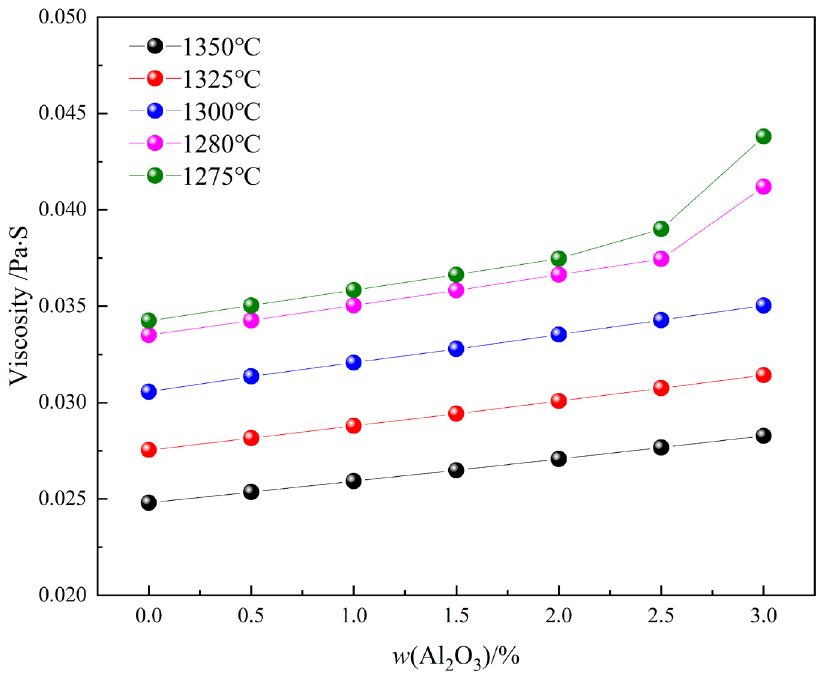
Figure 15. Viscosity diagrams of samples with Al 2 O 3 addition at different temperatures. The isothermal cross-sections of Fe 2 O 3 -CaO-SiO 2 -Al 2 O 3 systems with varying Al 2 O 3 content at different temperatures are shown in Figure 16. With the Al 2 O 3 content increasing, the liquid phase is divided into three regions, named L α , L α + L β , and L β , where the content of Al 2 O 3 increased from 1.0 to 3.0 mass pct. When the red component point is at 1250 ◦ C, the primary crystal region is transformed from L α + M 2 O 3 to L α + L β + α ’-C 2 S. There may be two reasons for the deterioration of crystallization. On the one hand, the viscosity of L α + L β + α ’-C 2 S is higher than that of L α +M 2 O 3 . In addition, the crystallization of α ’-C 2 S leads to the reducing of initial Ca 2+ and Si 4+ in the melt, which is not conducive to the crystallization of complex calcium ferrite. It can be seen from Figure 16 that when Al 2 O 3 is 2.0 mass pct, not only a certain amount of liquid phase is retained, but also Ca 2+ and Si 4+ are not reduced too much. This also explains that when Al 2 O 3 was 2.0 mass pct, the crystal size of calcium ferrite was the largest, as shown in Figure 13.